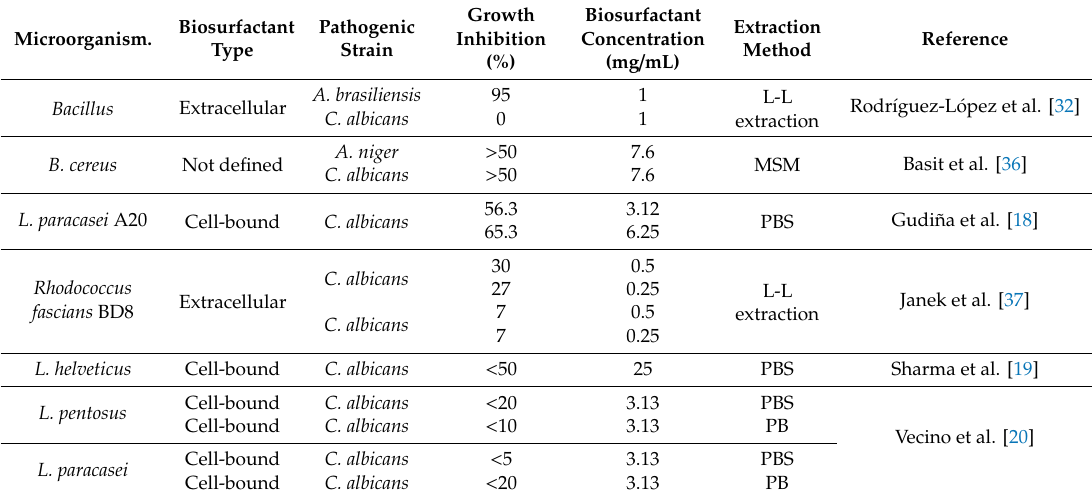
Table 5. Comparison of antifungal activity of di ff erent biosurfactants from the literature against A. brasiliensis (also named A. niger ) and C. albicans .